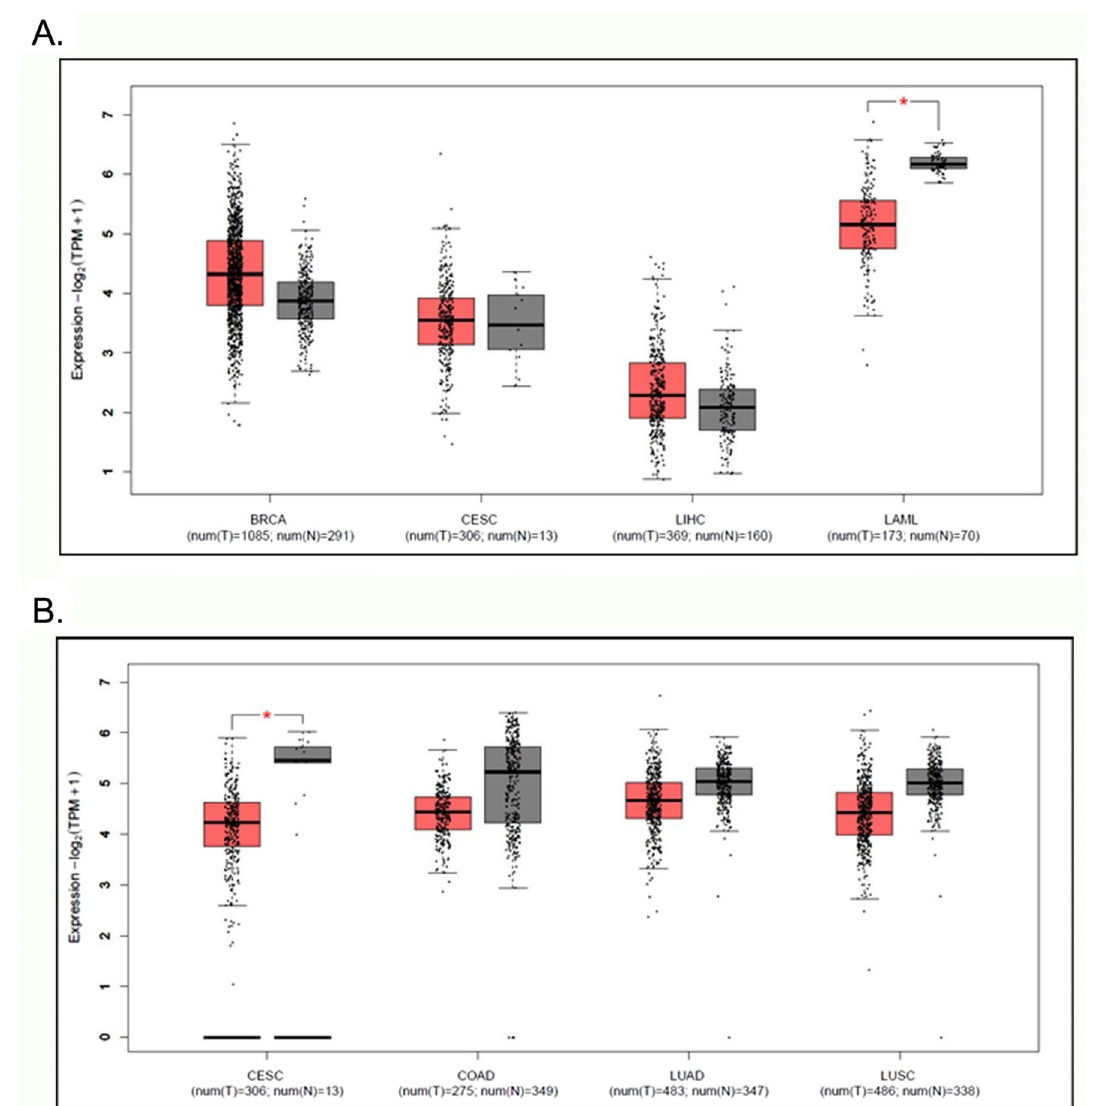
Fig. 4 Expression profile of ZMYND8 and 11 in cancer and control normal tissues. A The profile of ZMYND8 expression in cancers. The data- base derived scheme suggests that the levels of ZMYND8 in breast invasive carcinoma (BRCA) and hepatocellular carcinoma (LIHC) are elevated, while in cervical squamous cell carcinoma (CESC) the level is not different in malignant versus normal tissue; in AML (LAML) the expression level of ZMYND8 is remarkably downregulated (*p < 0.05). B The scheme of ZMYND11 expression with a new one with profile in different cancers. The expression of ZMYND11 is significantly downregulated in cervical carcinoma (*p < 0.05), and also slightly downregu- lated in colon adenocarcinoma (COAD), lung adenocarcinoma (LUAD), and lung squamous cell carcinoma (LUSC) (http:// gepia2. cancer- pku. cn/# analy sis, retrieved on November 21,